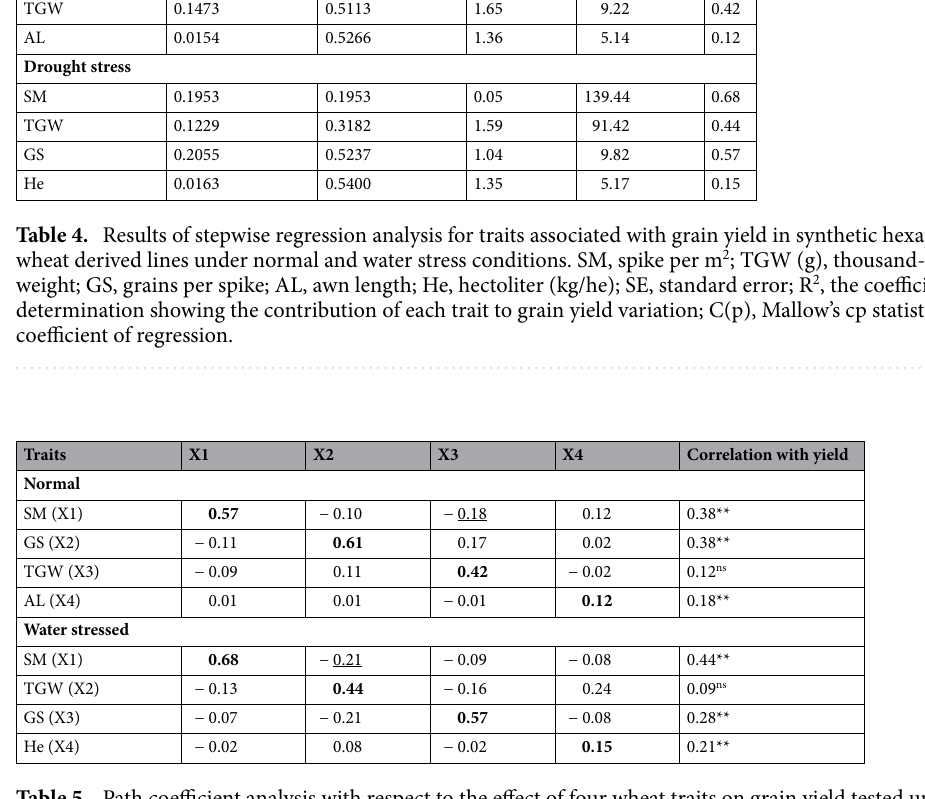
Table 5. Path coefficient analysis with respect to the effect of four wheat traits on grain yield tested under normal and water stress conditions over 2 years. ns; **Non-significant and significant at 0.01 probability level, respectively. Bold numbers on diagonal denote direct effects, out diagonal numbers indicate indirect effects of traits. Significant values are in underline. AL (cm), awn length; YLD (g/m 2 ), grain yield; SM, spike per m 2 ; TGW (g), thousand-grain weight; GS, grains per spike; He, hectoliter (kg/he).